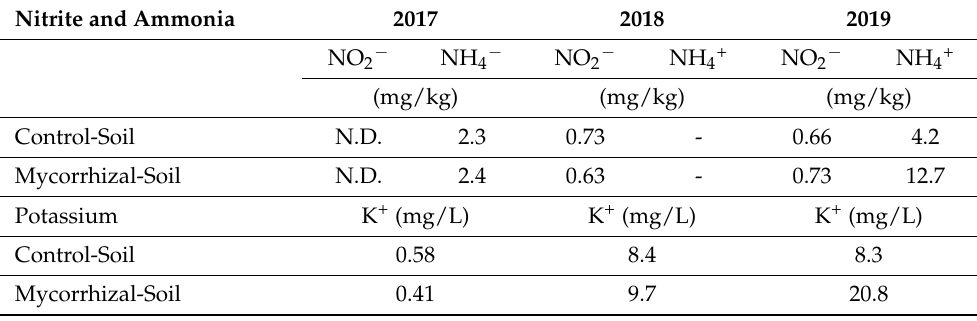
Table 1. Changes in levels of soil NK in plots of the host plant Helianthemum sessiliflorum mycorrhized by Terfezia boudieri . The plot was established in 2017 in the dune soil of the Negev Desert. Values are the means of three replicates. NO 2 : Nitrogen dioxide; N.D.: Not detected; NH 4 : Ammonia; and K: